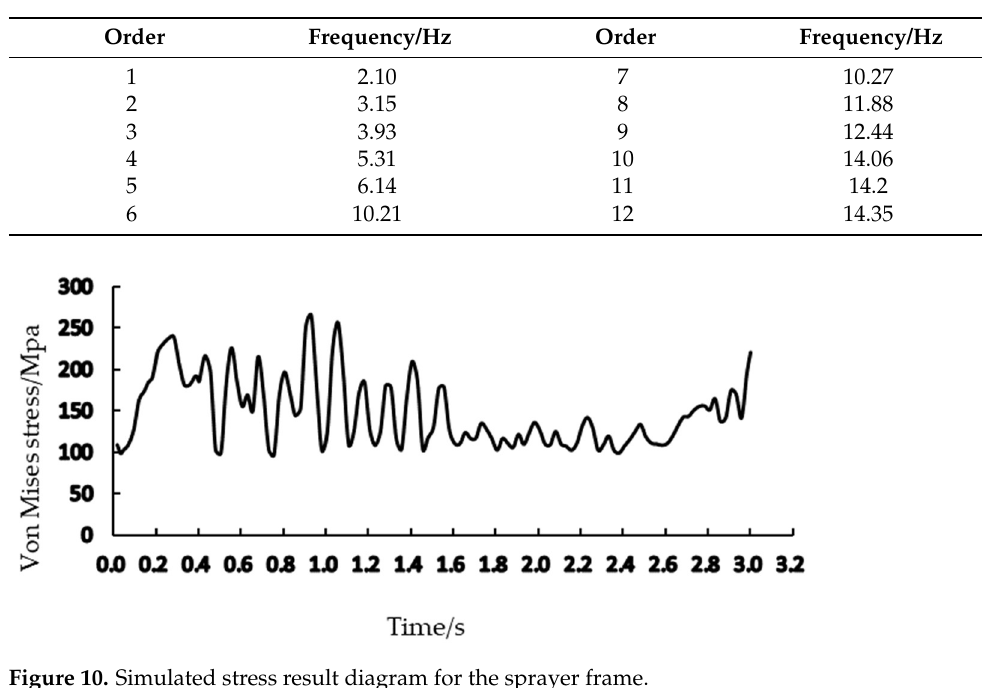
Figure 10. Simulated stress result diagram for the sprayer frame.